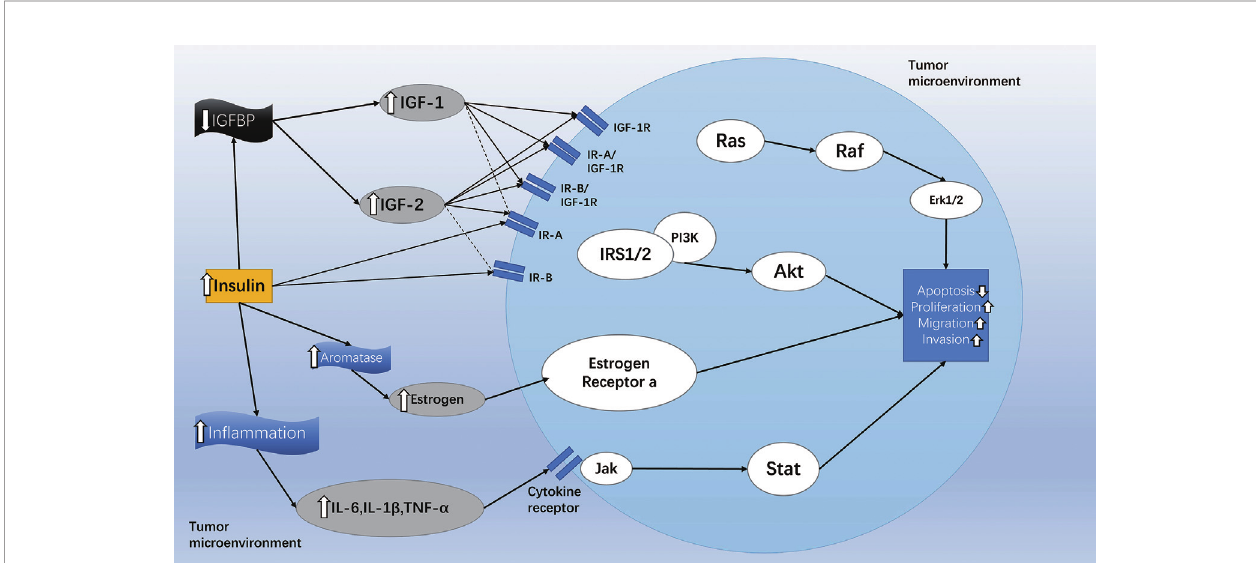
FIGURE 5 | The effect of diabetes on tumor cell microenvironment and intracellular signaling transduction. Diabetic patients can increase their levels of insulin and stimulate the PI3K/Akt/mTOR, Ras/Raf/MAPK, and Jak/Stat signaling pathways in different ways, thereby inhibiting cancer cell apoptosis and promoting the spread, migration, and invasion of cancer cells. Solid arrows indicate strong af fi nity for the receptor, and dashed arrows represent weak af fi nity for the receptor. The fi gure is modi fi ed from Ref